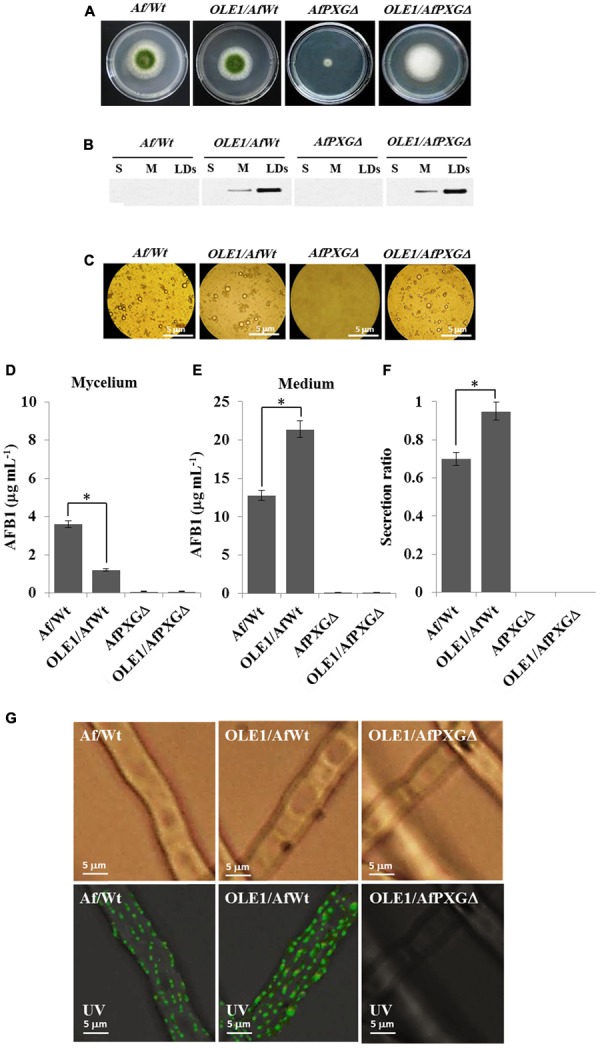
Effect of the oleosin1 (OLE1) expression on fungal growth and AFB1 secretion. (A) Five-day-old cultures of transformants OLE1/AfWt and OLE1/AfPXGΔ compared with their respective background lines AfWt and AfPXGΔ. (B) Immunodetection of OLE1 protein in different subcellular fractions, supernatant (S), microsomes (M), and lipid droplets (LDs) isolated from the transformants OLE1/AfWt and OLE1/AfPXGΔ compared with their respective background lines. (C) Light micrographs of the isolated LDs from the respective lines. (D,E) Quantification of AFB1 production in fungal mycelia and in the culture medium of transformants compared with background lines. (F) Secretion ratio of AFB1 by both transformants (calculated as ratio of AFB1 in the medium to AFB1 in medium plus mycelia in a 100 mL culture) compared with control lines. (G) Fluorescence image showing aflatoxin on the cell surface. The immunodetection of AFB1 was performed by its primary antibody coupled with a FITC-labeled secondary antibody. The measurements were done in triplicates. Values are means ± SD (n = 3). The differences in AF production between lines were significant when analyzed by t-test (∗P < 0.05).